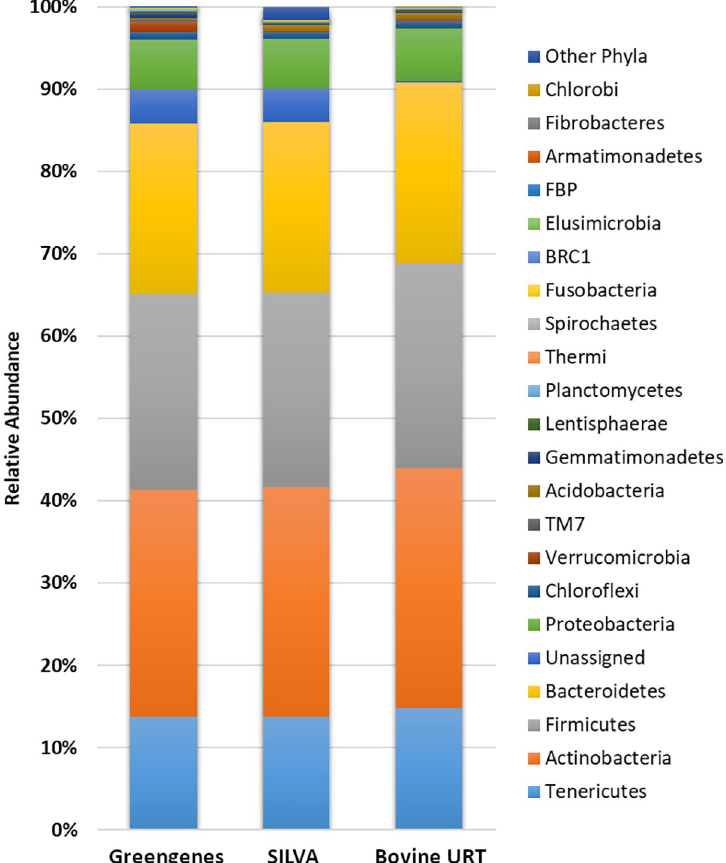
Fig 4. Relative abundance of bacterial phyla in the multiple diverse samples identified using the Greengenes, SILVA, and Bovine URT databases on small read 16S amplicon sequencing from the bovine URT. https://doi.org/10.1371/journal.pone.0235498.g004 URT. The rarefaction curve of the sequences utilized in the Bovine URT database indicates that the level of sequencing depth was adequate to detect the majority of the microbial commu- nities across the dataset. Taking into account the use of near full length 16S reads, deep sequencing depth, variable health statuses, and a large sample population of cattle, the con- structed Bovine URT 16S rDNA database represents one of the more comprehensive microbial datasets to date with reference to BRD.